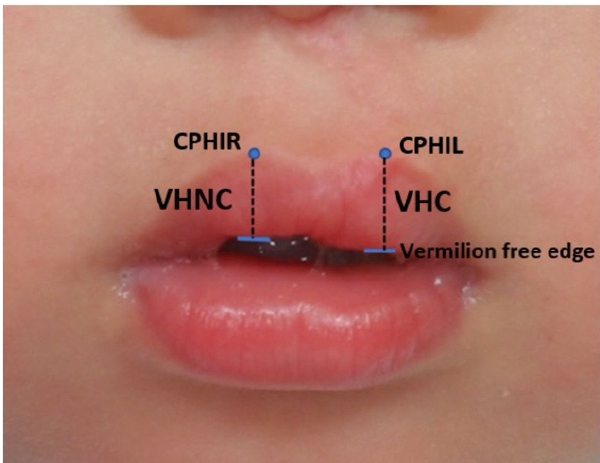
Figure 1. Landmarks and measurement of the upper lip vermilion height. A one-year-old boy who underwent cheiloplasty for an incomplete cleft lip. Landmarks: crista philtri inferior right (CPHIR), crista philtri inferior left (CPHIL), and vermilion-free edge (indicated by the horizontal blue line). Measurements: VHC, vermilion height cleft side; VHNC, vermilion height non-cleft side. Three time intervals (T1, T2, and T3) were considered for comparison of the same patient for both the incomplete and complete cleft types (Figures 2 and 3).